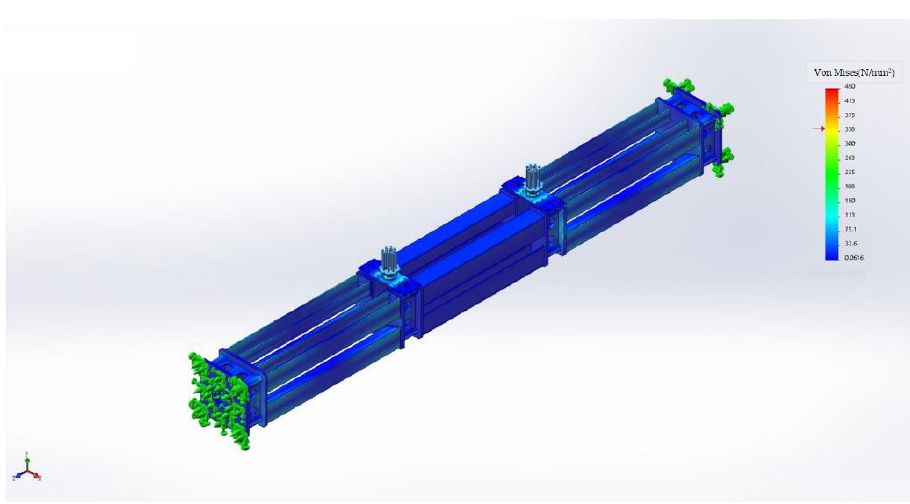
Figure 6. Stress cloud diagram under bending moment load.